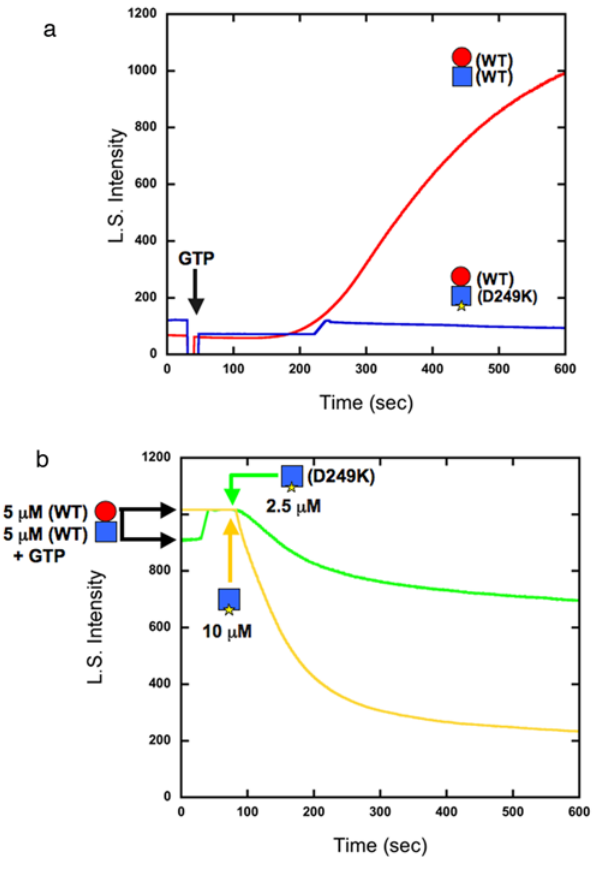
Figure 2. Between-dimer mutant BtubB-D249K fails to assem- ble and disassembles wild type polymers. (a) Assembly of 5 m M each wild type BtubA plus BtubB is shown by the red curve. The time of GTP addition is indicated. The blue curve shows that wild type BtubA plus BtubB-D249K gave no assembly. (b) polymers were first assembled to steady state from 5 m M each wild type BtubA and BtubB. At the arrows BtubB-D249K was added to 2.5 m M or 10 m M, causing disassembly.